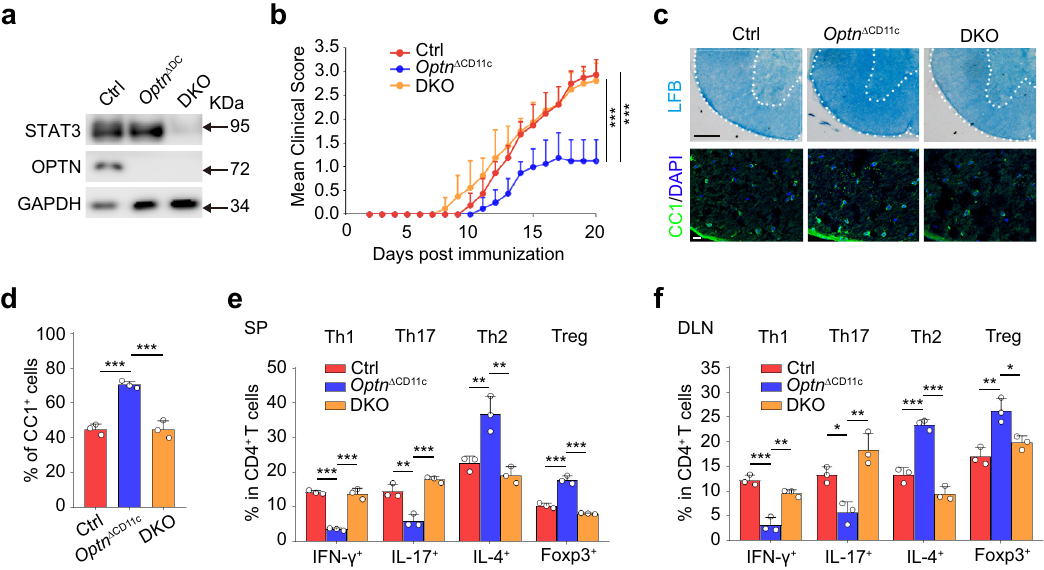
Fig. 5 Deletion of Stat3 aggravates autoimmunity in Optn Δ CD11c mice. a Western blotting to verify the de fi ciency of OPTN and STAT3 in DKO DCs. n = 3 independent experiments. b Mean clinical scores of Ctrl, Optn Δ CD11c and DKO mice (8-week-old, female) subjected to MOG 35 – 55 -induced EAE. n = 8 independent animals, P (Ctrl) = 5.1E − 08, P (DKO) = 1.6E − 07. c (Upper) Luxolfast blue (LFB) staining of spinal cords from indicated EAE mice at day 20. Scale bars, 200 μ m. (Lower) Immuno fl uorescent labeling of CC1 (green) and DAPI (blue) in the spinal cord of indicated mice at day 20. Scale bars, 20 μ m. n = 3 independent animals. d The summary graphs of CC1 + cells in ( c ). n = 3 independent animals, P (Ctrl) = 0.0003, P (DKO) = 0.0003. e , f Frequency of Th1, Th17, Th2, and Treg cells in the spleen (SP) ( e ) and draining lymph nodes (DLN) ( f ) from indicated EAE mice on day 20 after immunization. n = 3 independent animals, P (Ctrl) = 2.3E − 05, P (DKO) = 2.8E − 05 of IFN- γ in ( e ); P (Ctrl) = 0.0018, P (DKO) = 0.0003 of IL-17 in ( e ); P (Ctrl) = 0.0059, P (DKO) = 0.0020 of IL-4 in ( e ); P (Ctrl) = 7.1E − 05, P (DKO) = 1.5E − 05 of Foxp3 in ( e ); P (Ctrl) = 0.0002, P (DKO) = 0.00102 of IFN- γ in ( f ); P (Ctrl) = 0.0215, P (DKO) = 0.0018 of IL-17 in ( f ); P (Ctrl) = 0.0002, P (DKO) = 3.2E − 05 of IL-4 in ( f ); P (Ctrl) = 0.0026, P (DKO) = 0.0155 of Foxp3 in ( f ). Data are presented